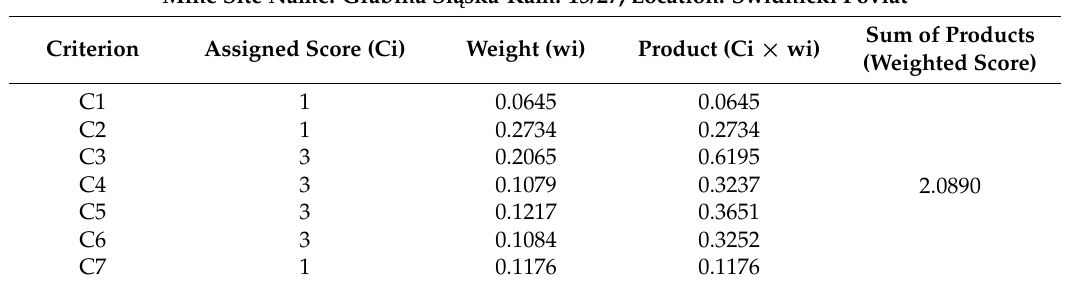
Table 3. Sample procedure for calculating the final weighted score (Grabina ´Sl ˛aska-Kam.15/27 site).